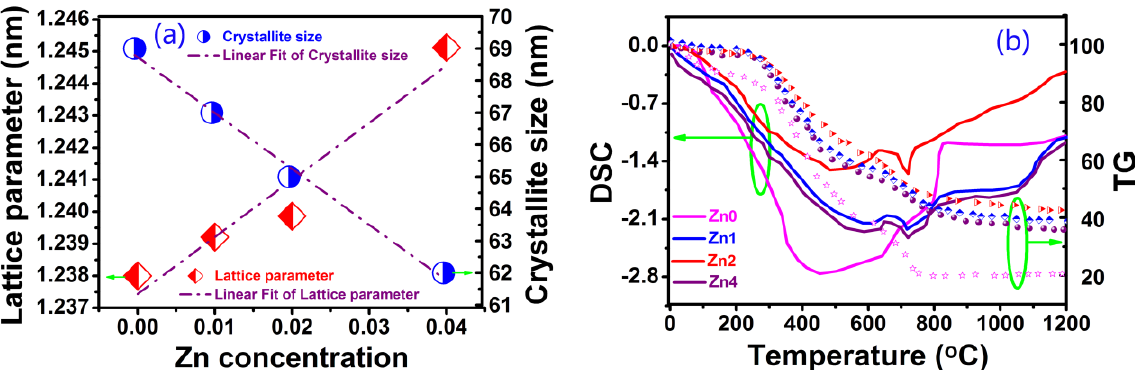
Figure 2. ( a ) The variation of lattice constant and crystallite size and ( b ) TG — DSC curves of dried gel.